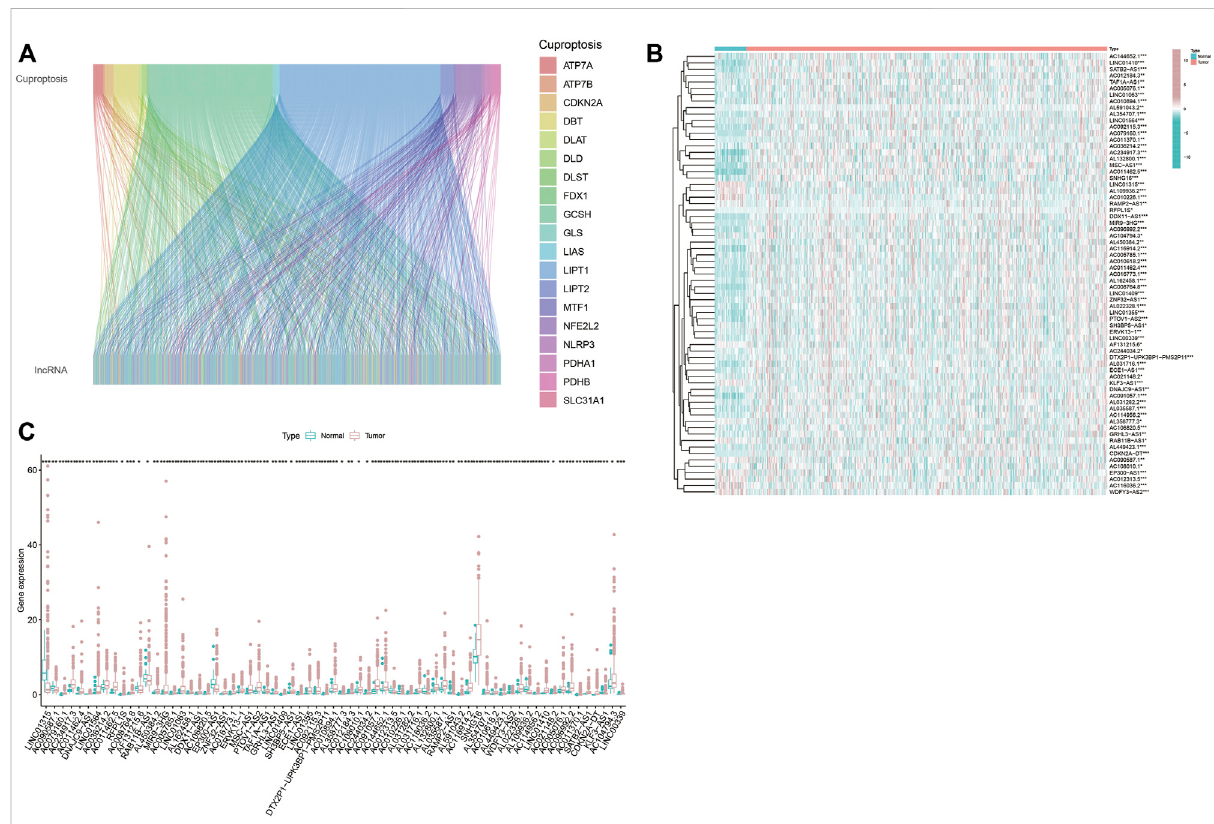
FIGURE 1 Screen out hub lncRNAs. (A) Sankey diagram showed the associations between the 19 cuptoptosis-related genes and the associated lncRNAs. (B,C) Differentialexpressionsofthe69prognosticcuproptosis-relatedlncRNAsbetweenthenormalandtumorsamplesinHNSC.* p < 0.05,** p < 0.01,*** p <